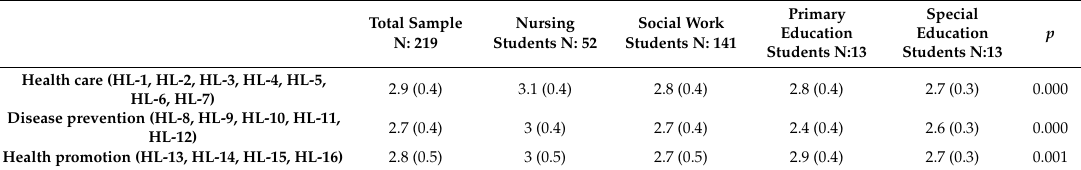
Table 2. Average scores of the HLS-EU-Q16 subdomains in the total sample. Total Sample Nursing N: 219 Students N: 52